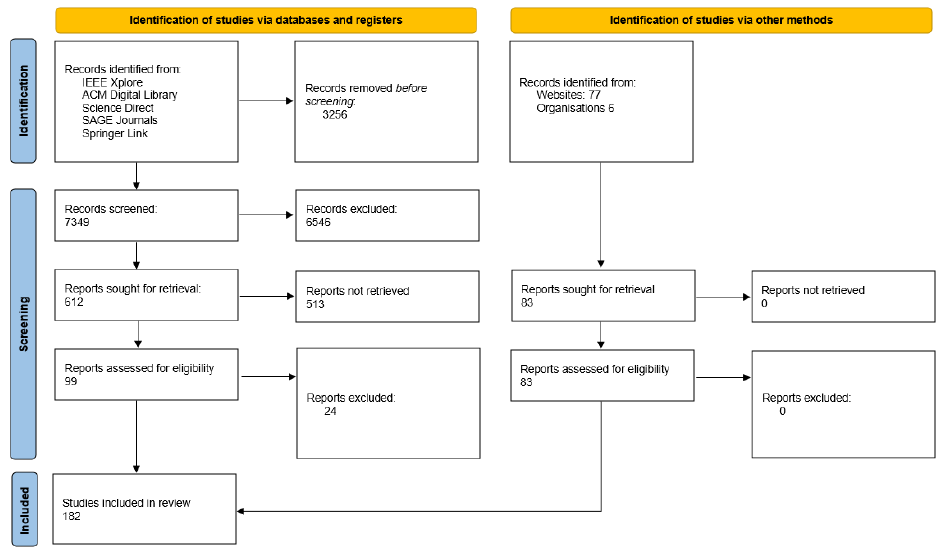
Figure 1. PRISMA 2020 flow diagram for systematic reviews.